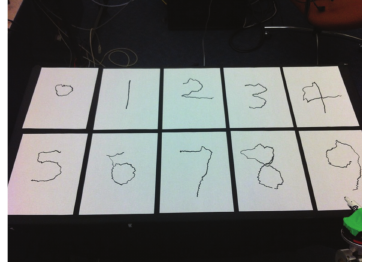
Figure 17: Letters written by